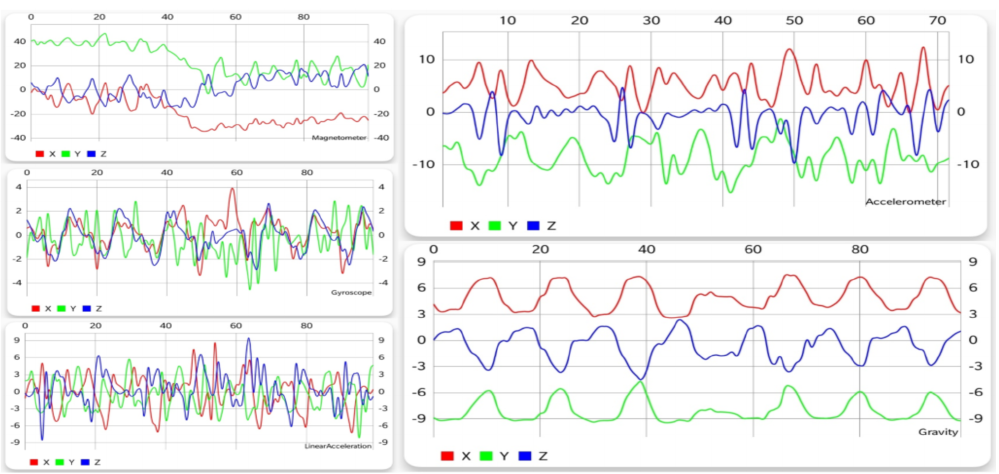
Figure 6. Graphical data gathered from each sensor while climbing